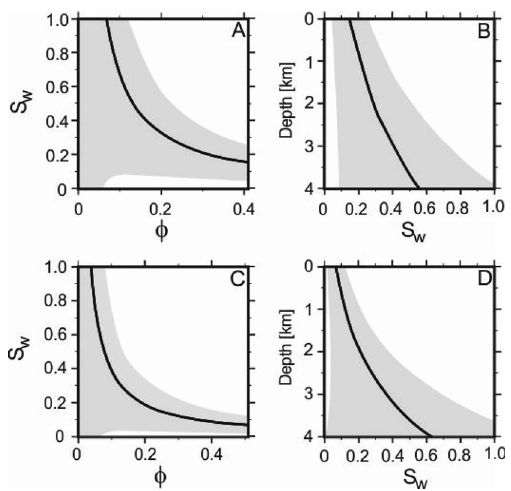
Figure 9. Connate water saturation ( S w ) as a function of porosity and depth calculated using parameters for sandstone and carbonate and Athy’s relation 7,48,53 . ( A , B )= sandstone, ( C , D ) = carbonate. Grey regions represent uncertainties calculated using upper and lower bounds of experimental constants for Eq. (14) 53 . Uncertainties beyond depths of 2 km become significant, hence we do not extend this method beyond this